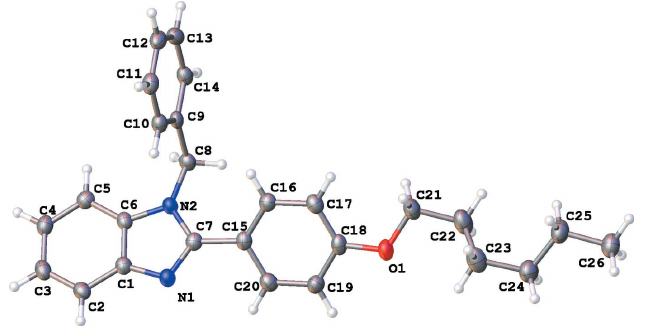
Figure 3 The molecular structure of 1 - benzyl-2-(4-hexyloxyphenyl)-1 H- benzimid- azole ( 3 ), with displacement ellipsoids drawn at the 50% probability level.